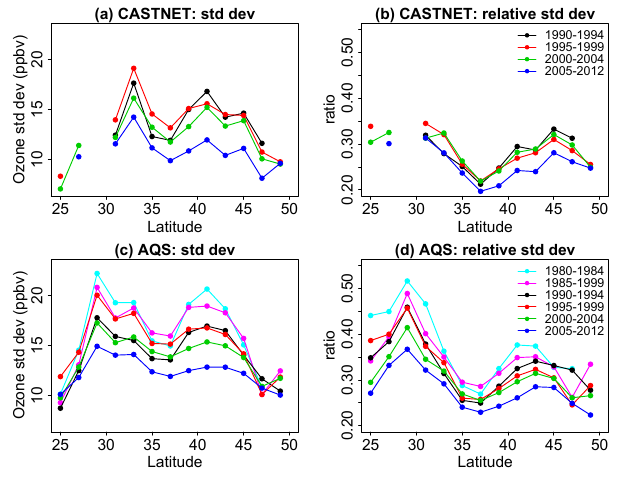
Figure 1. Latitudinal variation of zonal mean ozone standard devia- tion (a, c) and relative standard deviation (b, d) from CASTNET (a, b) and AQS (c, d) , averaged between 100 and 65 ◦ W longitude and binned to 2 ◦ intervals in latitude. All values are for JJA mean MDA8 ozone. The different colors denote different 5-year time intervals except for the most recent interval, which is 8 years in